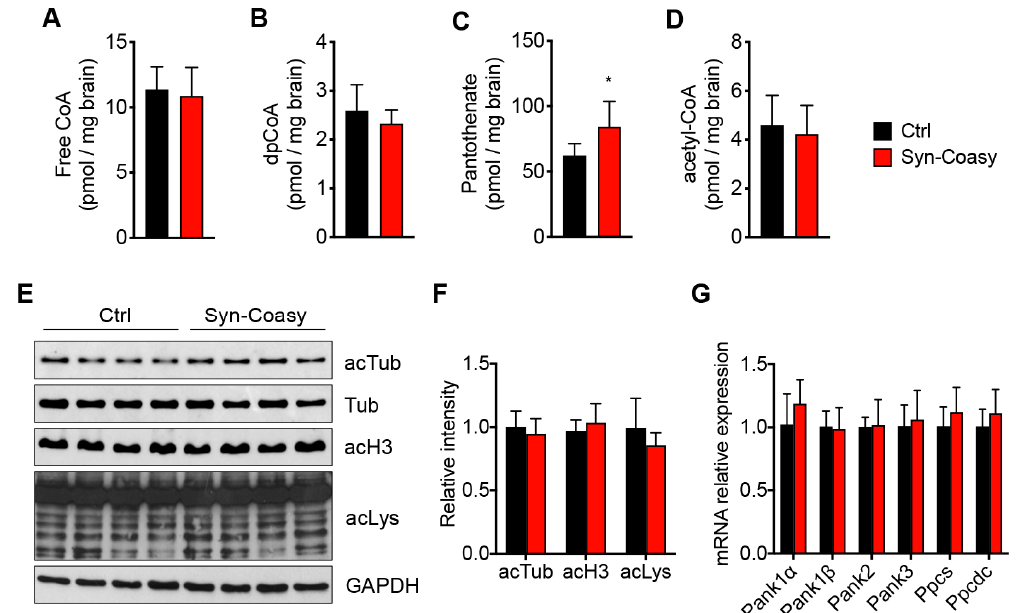
Figure 3. CoA biosynthesis and protein acetylation. Mass spectrometry quantification of ( A ) free CoA, ( B ) dpCoA, ( C ) pantothenate, and ( D ) acetyl-CoA in the forebrain from Ctrl ( n = 6) and Syn-Coasy ( n = 6) mice (age P12–P14). * p < 0.05 (Student’s t-test). ( E ) Western blot analysis and ( F ) densitometric